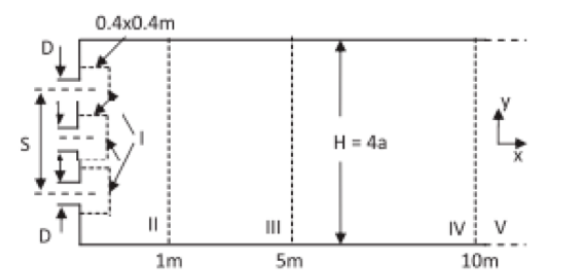
Figure 1: The two dimensional solution domain with three jets in a confined